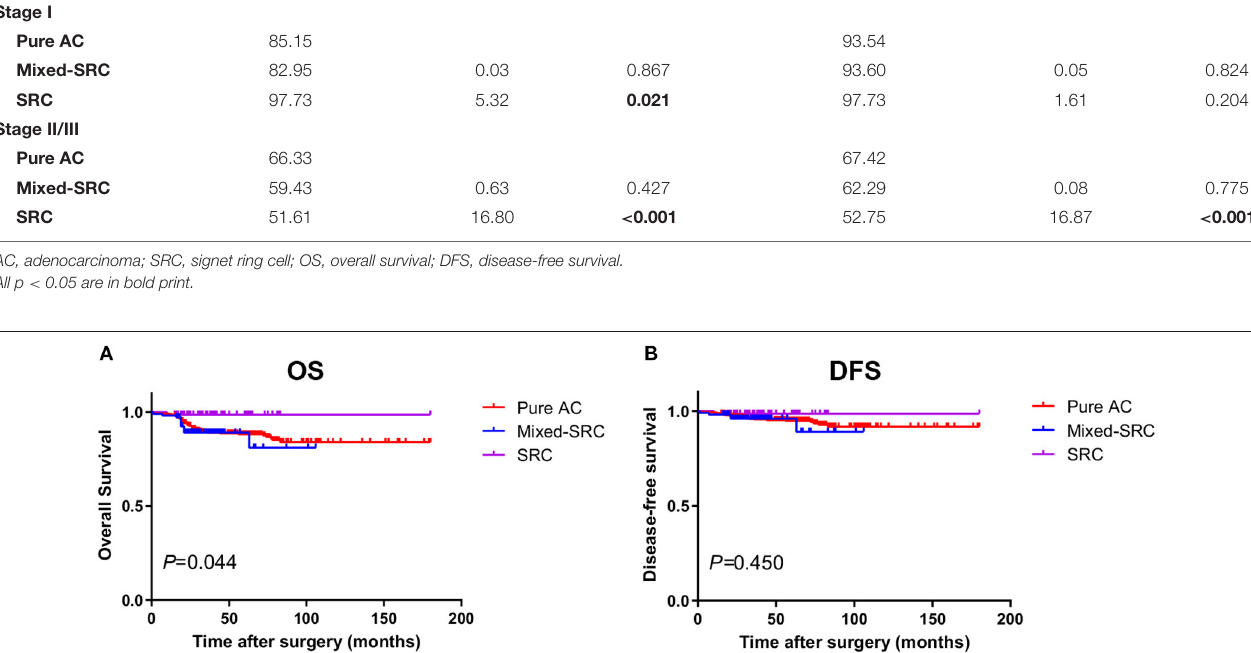
FIGURE 2 | The Kaplan–Meier survival curves of overall survival (OS) (A) and disease-free survival (DFS) (B) in gastric cancer patients in stage I.